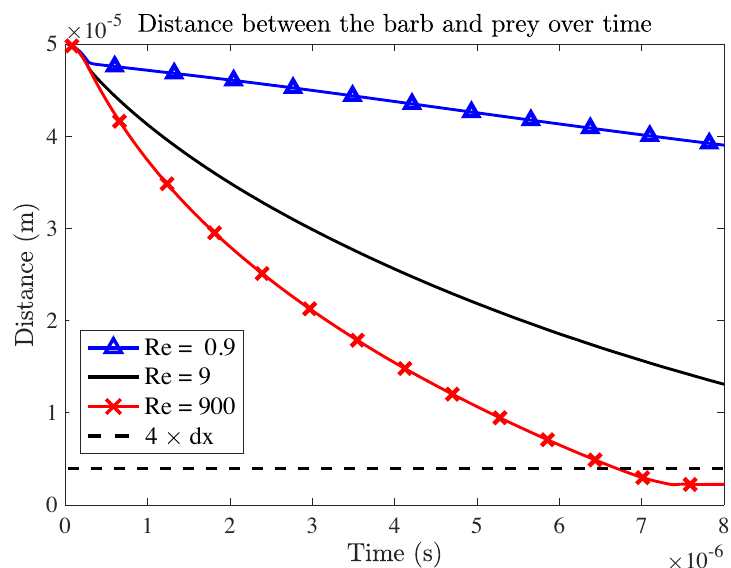
Figure 8. The distance between the top of the barb and the closest point on the prey as a function of time for Re = 0.9, 9, and 900. The dashed black line denotes the threshold value of 4 dx , where the value of dx is taken to be at the most refined grid level. Other simulation parameters are located in Table 2.